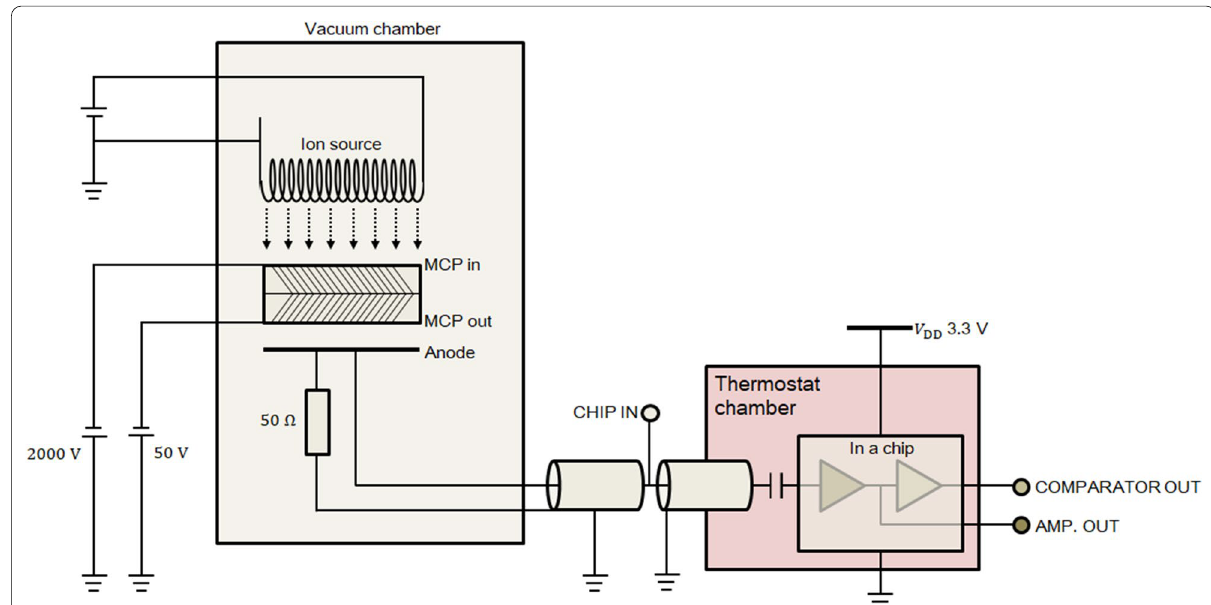
Fig. 6 Measurement configuration used to evaluate the performance of the designed chip. The MCP is installed inside a vacuum chamber. When an ion hits the MCP, a current pulse is emitted from the anode and fed into the chip. Three monitoring points are indicated by circles: the input of the current pulse amplification circuit (CHIP IN), the output of the current pulse amplification circuit (AMP OUT), and the output of the comparator (COMPARATOR OUT). When measuring the temperature dependence of the amplifier performances, we placed the chip in the thermostat chamber and varied the temperature from − 20 to 60 ◦ C